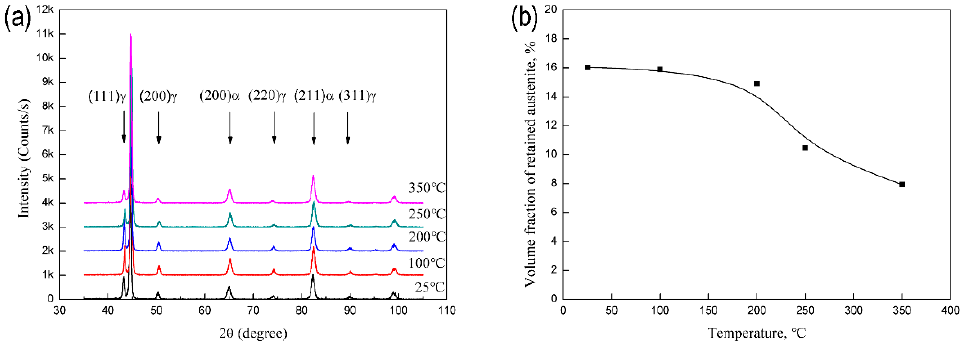
Figure 2. The steel held at different temperatures for 600 s: ( a ) XRD spectra; ( b ) evolution of V RA versus deformed temperature.